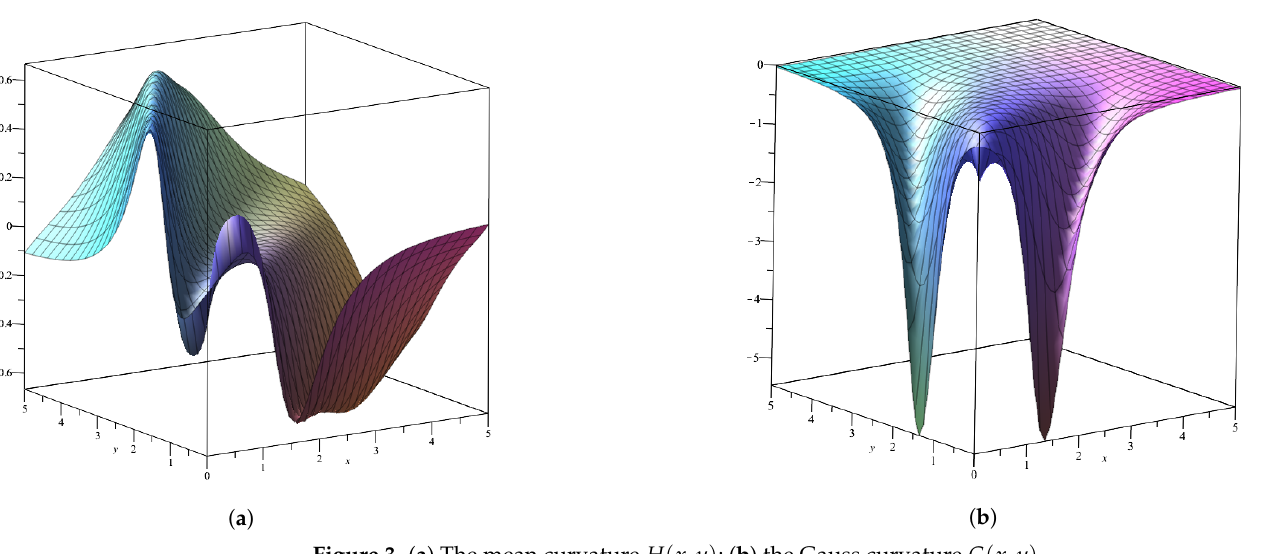
Figure 3. ( a ) The mean curvature H ( x , y ) ; ( b ) the Gauss curvature G ( x , y